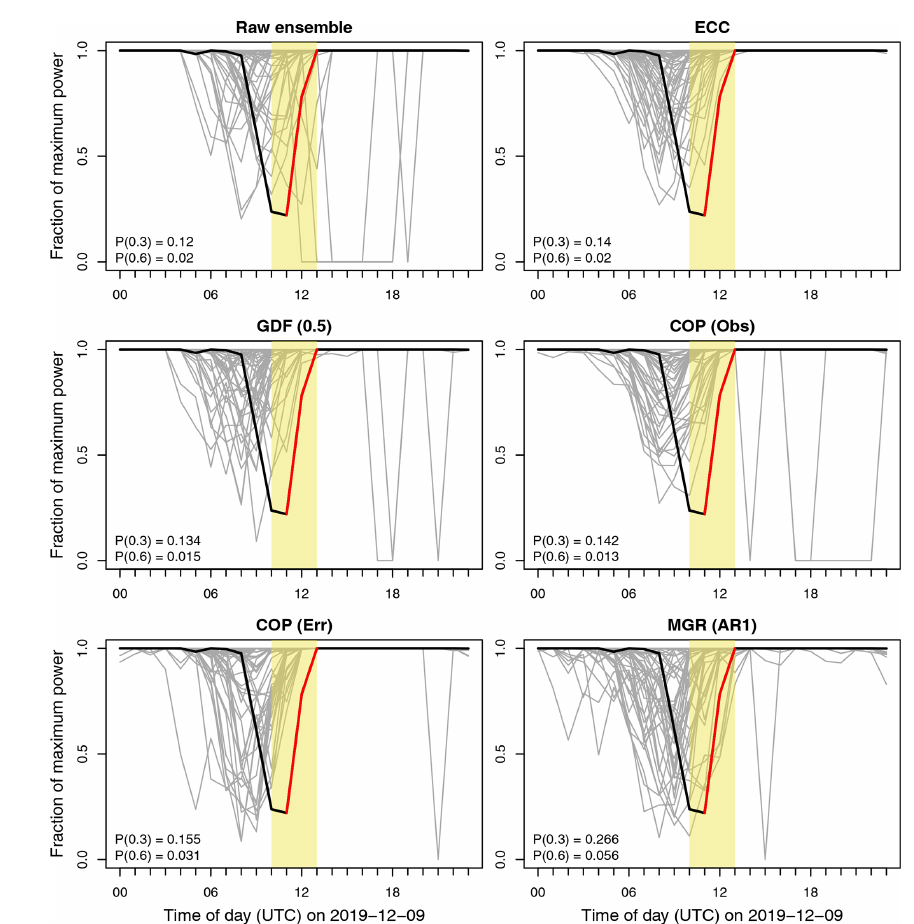
Figure 4. The next-day hourly forecasts ( + 24 to + 47h) from Fig. 1, but transformed into power space using the theoretical curve of Fig. 3. Thick black lines are transformed wind speed observations, and thin grey lines are transformed wind speed forecast scenarios. A very strong power ramp with magnitude approximately 0.7 (red line) was observed to occur within a specific time window (yellow shading). Power forecasts were used to derive ramp probabilities for up ramps exceeding 0.3 and 0.6 within this time window. They are included as P (0.3) and P (0.6),